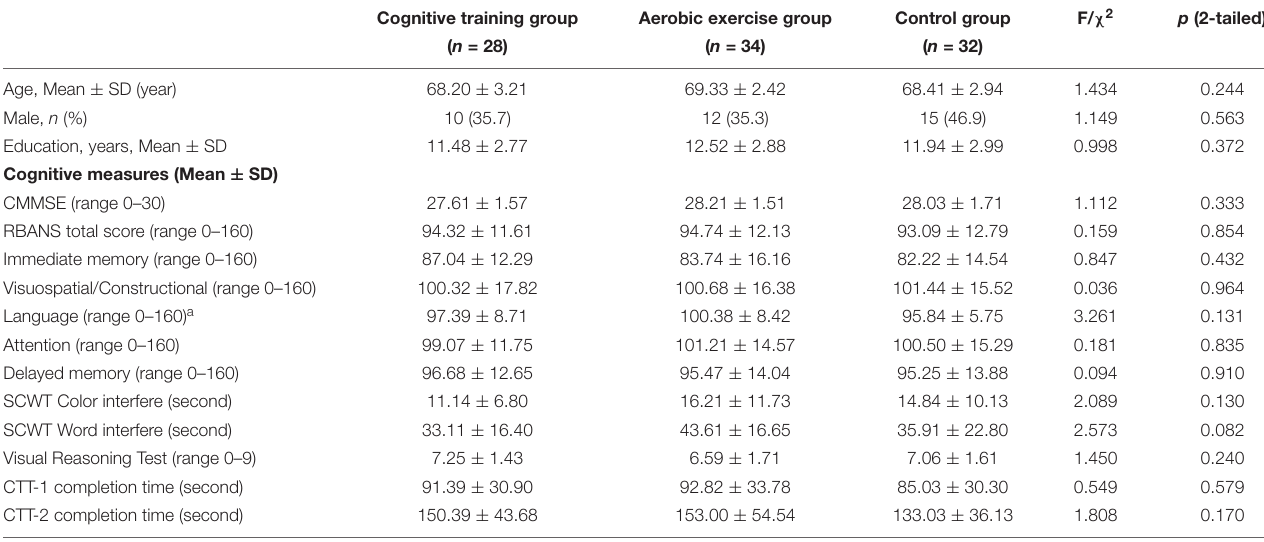
TABLE 1 | Demographic characteristics and cognitive measures of participants at baseline. Cognitive training group Aerobic exercise group Control group F/ χ 2